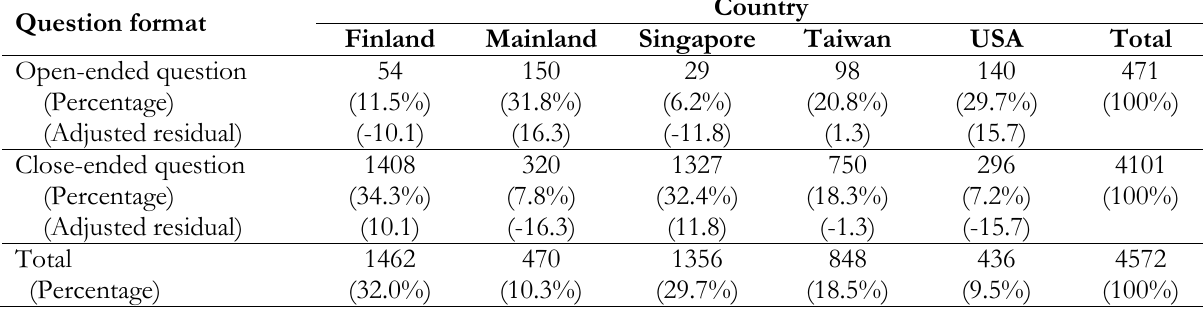
Table 3. Cross-tabulation of question format and country with adjusted residuals